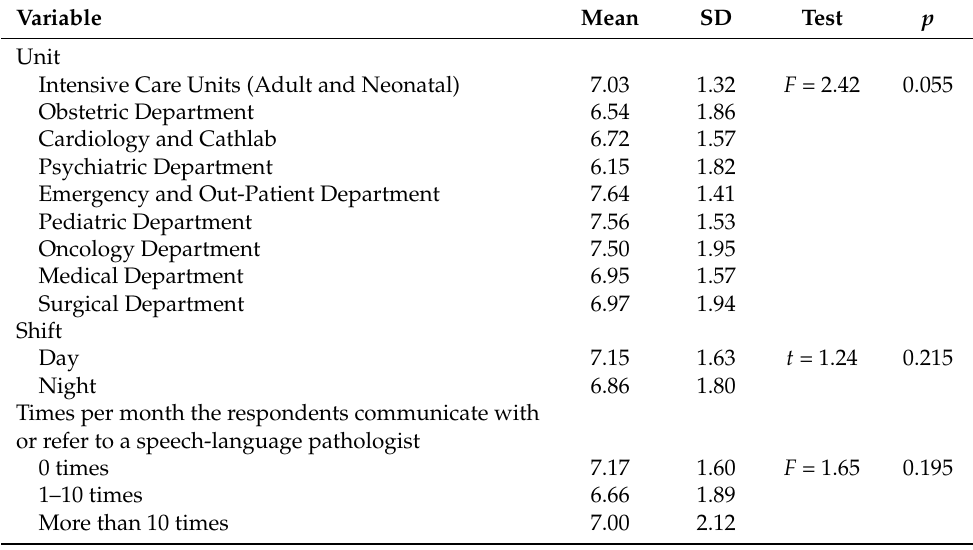
Table 5. Results of the Tests for Differences and Associations between the Work-Related Characteris- tics and Understanding of the Speech-Language Pathologist’s Scope of Practice (N = 294).